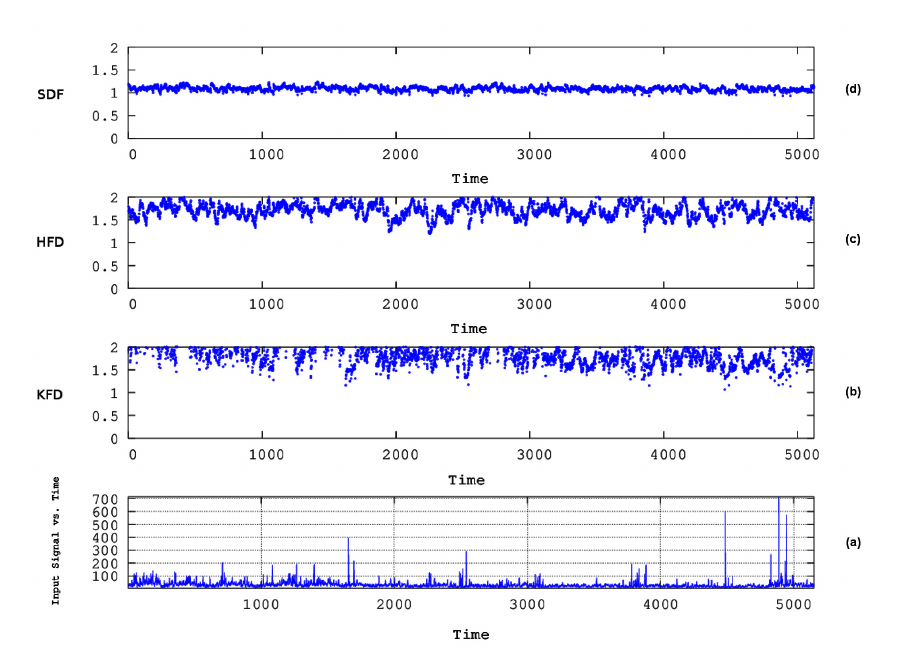
Figure 2. Time evolution of the fractal dimension of the PM 10 time series recorded by the AGP station between the years 2001–2016. From bottom to top: ( a ) time series (mean daily values/concentrations) and fractal dimensions according to the algorithms of ( b ) Katz (KFD) ( c ) Higuchi (HFD), and ( d ) Sevcik (SFD). PM 10 concentration in µ g/m 3 . Time is in days (sample number). Each analysis window contains 64 samples.